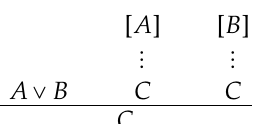
Figure 2. ∨ -Elimination as a natural deduction